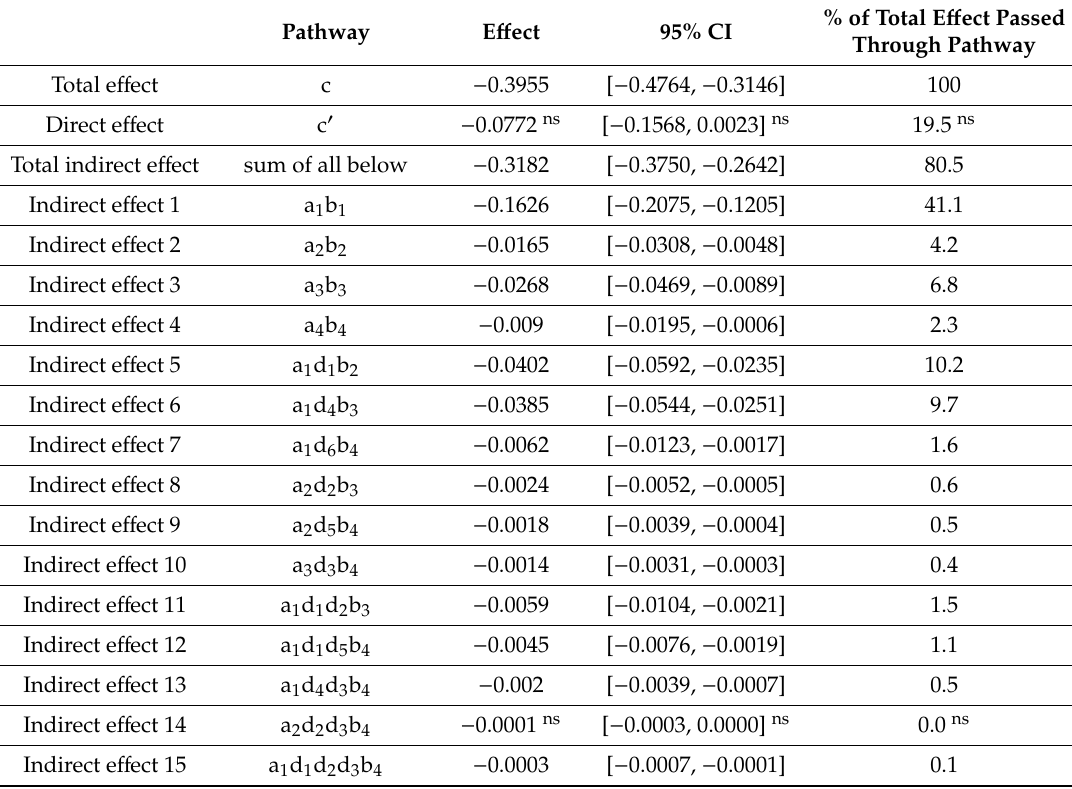
Table 3. Direct and indirect e ff ects with 95% Confidence Inverval (95% CI) for mediating pathways of the relationship between stress in 2012 and work ability in 2017 ( N =